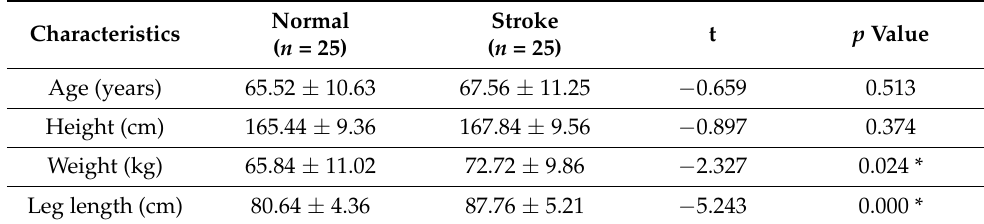
Table 1. General characteristics according to group.